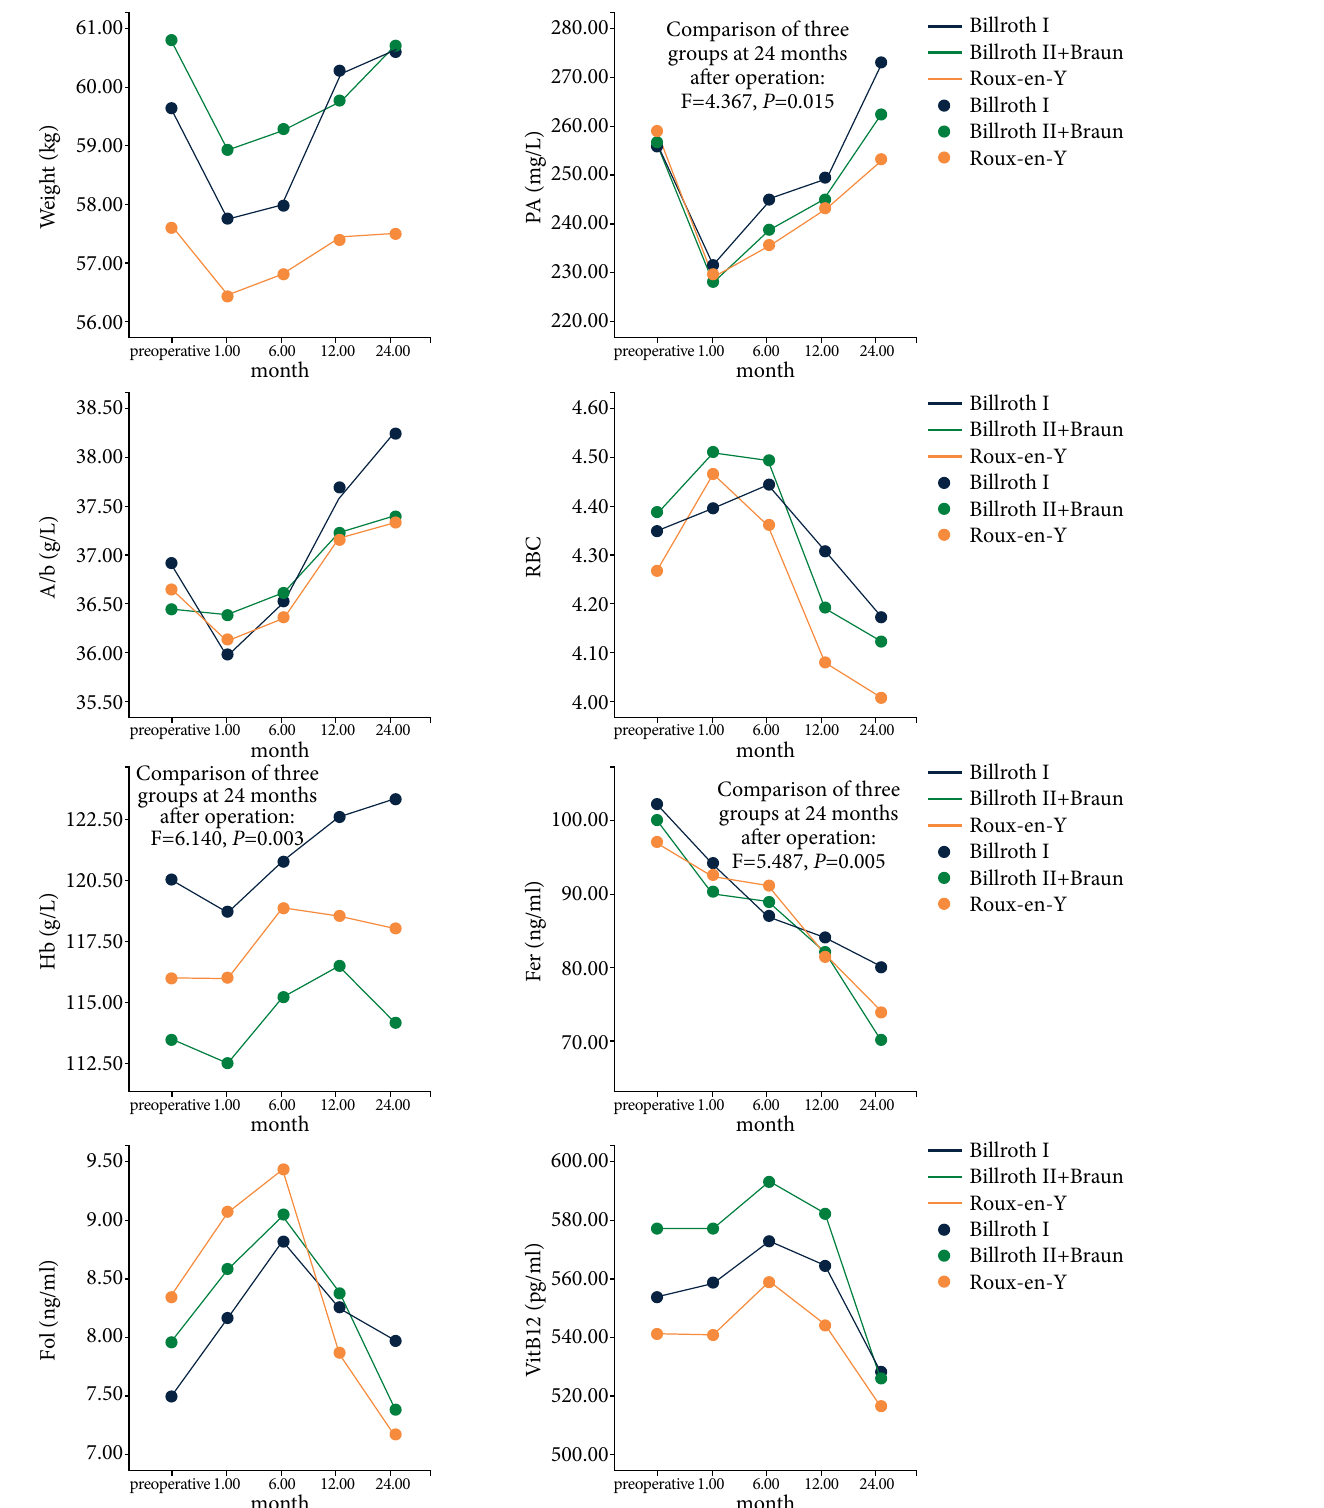
Figure 1 - Change curve of nutritional indicators and anaemic indicators.